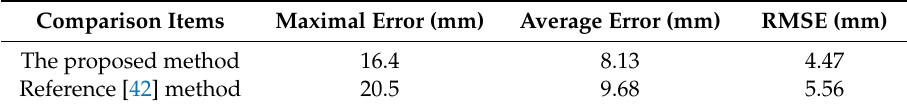
Table 4. Detailed performance comparison results of the two methods.